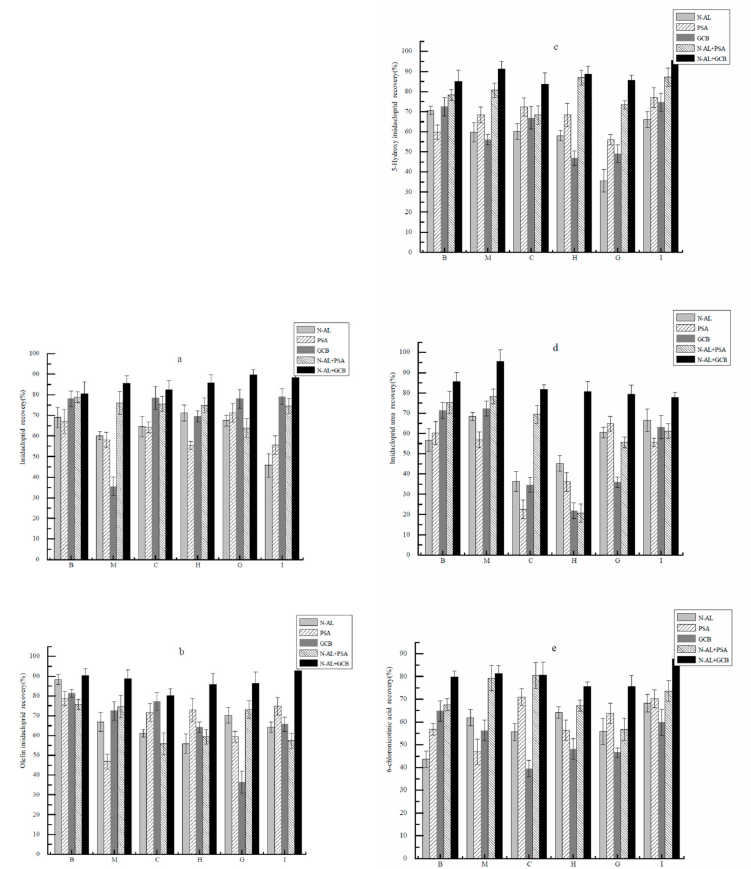
Figure 5. Effects of different purification materials on the recoveries of imidacloprid ( a ), olefin imidacloprid ( b ), 5-hydroxy imidacloprid ( c ), imidacloprid urea ( d ) and 6-chloronicotinic acid ( e ) from P. clarkii homogenates. PSA, primary secondary amine; GCB, graphitized carbon black; N-AL + PSA, neutral alumina and primary secondary amine; N-AL + GCB, neutral alumina and graphitized carbon black. See Figure 4 for